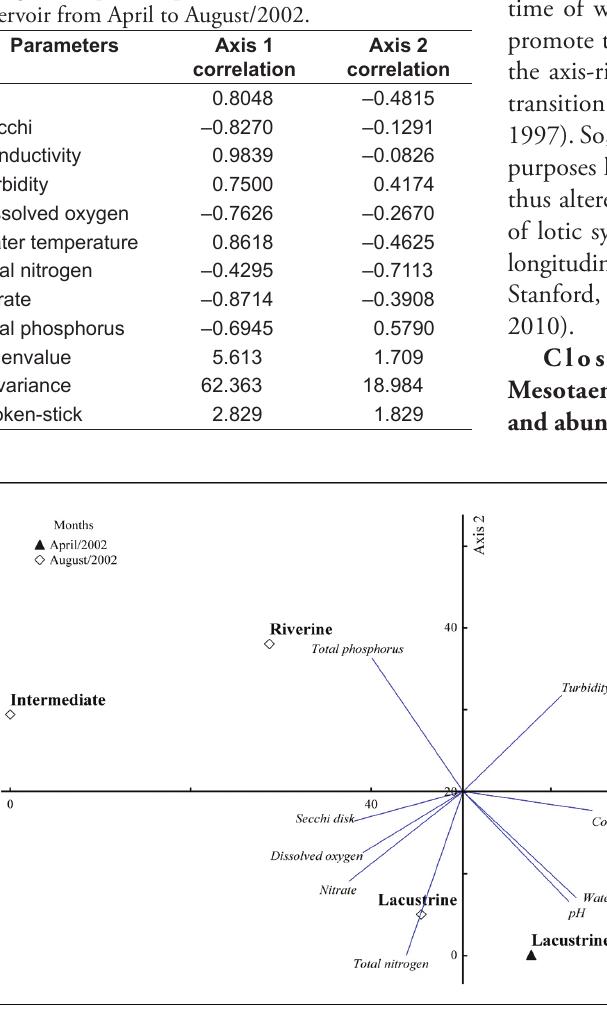
Figure 2. Principal Component Analysis (PCA) for physi cal and chemical parameters analyzed for the six sampling sites along the Rosana Reservoir, from April/2002 and